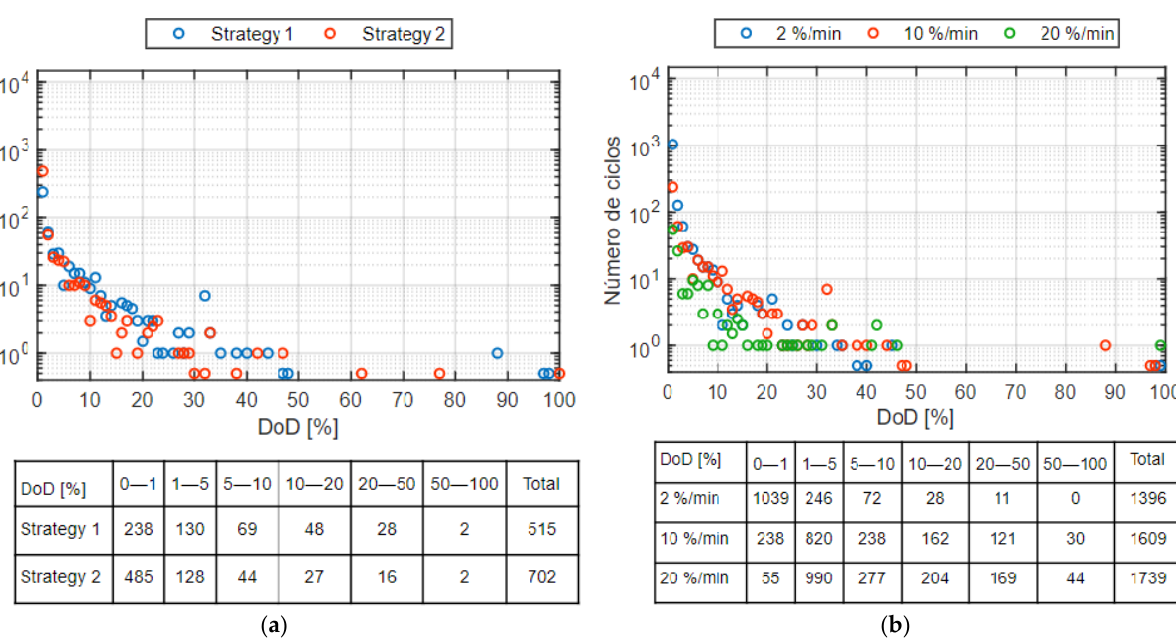
Figure 9. Number of cycles observed at a given discharge depth (DoD) for the 1 MWp PV plant. ( a ) Each strategy and r max = 10 %/min, ( b ) Strategy 1 for r max = 2 %/min, r max = 10 %/min and r max = 20 %/min.